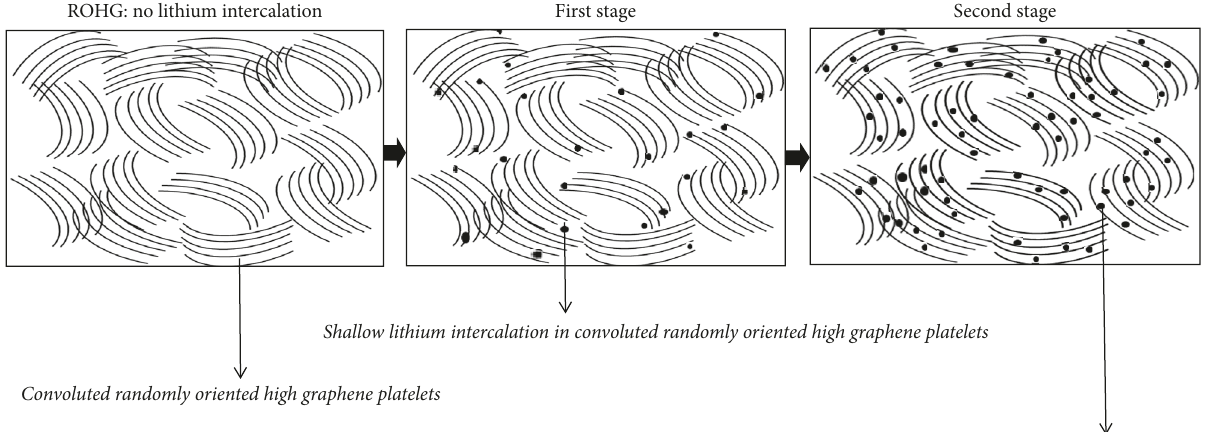
Figure 8: Predicted model for different stages of lithium intercalation in